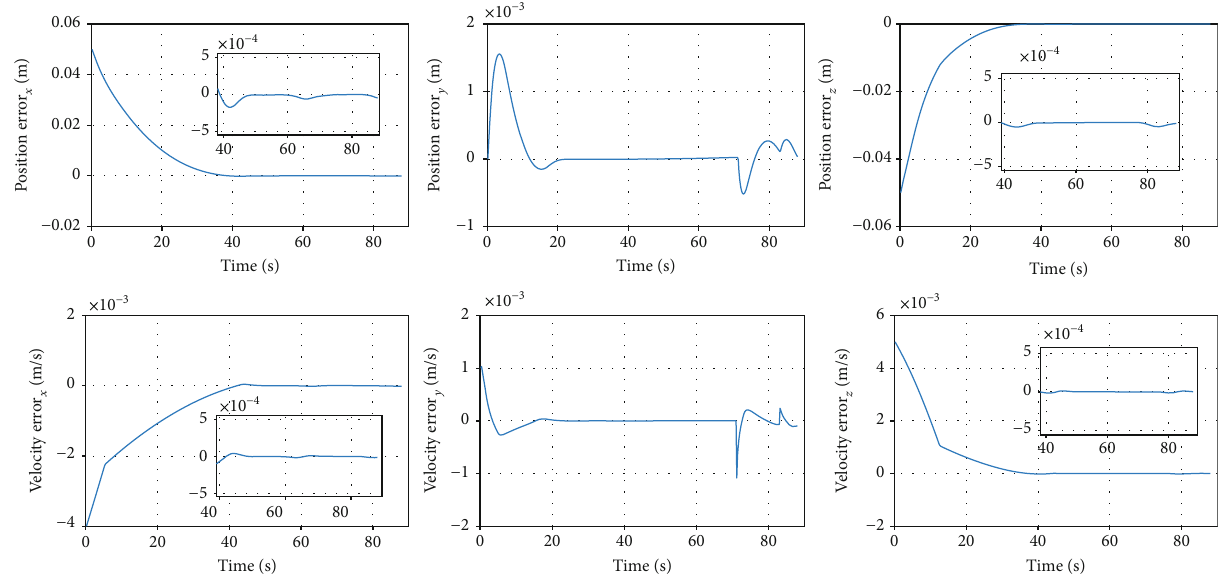
Figure 20: Position tracking errors and velocity tracking